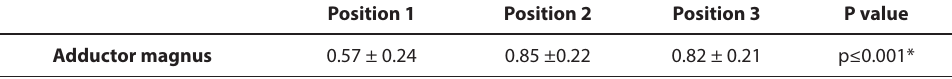
TABLE 2. The mean ±SD of normalized peak EMG amplitudes of adductor magnus during each test position